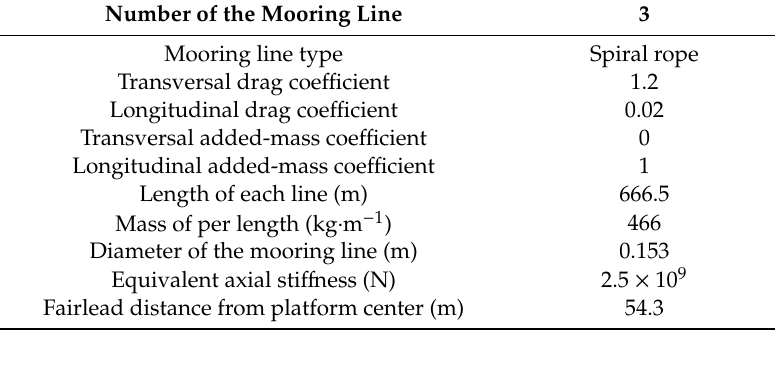
Table 4. Properties of the mooring system.